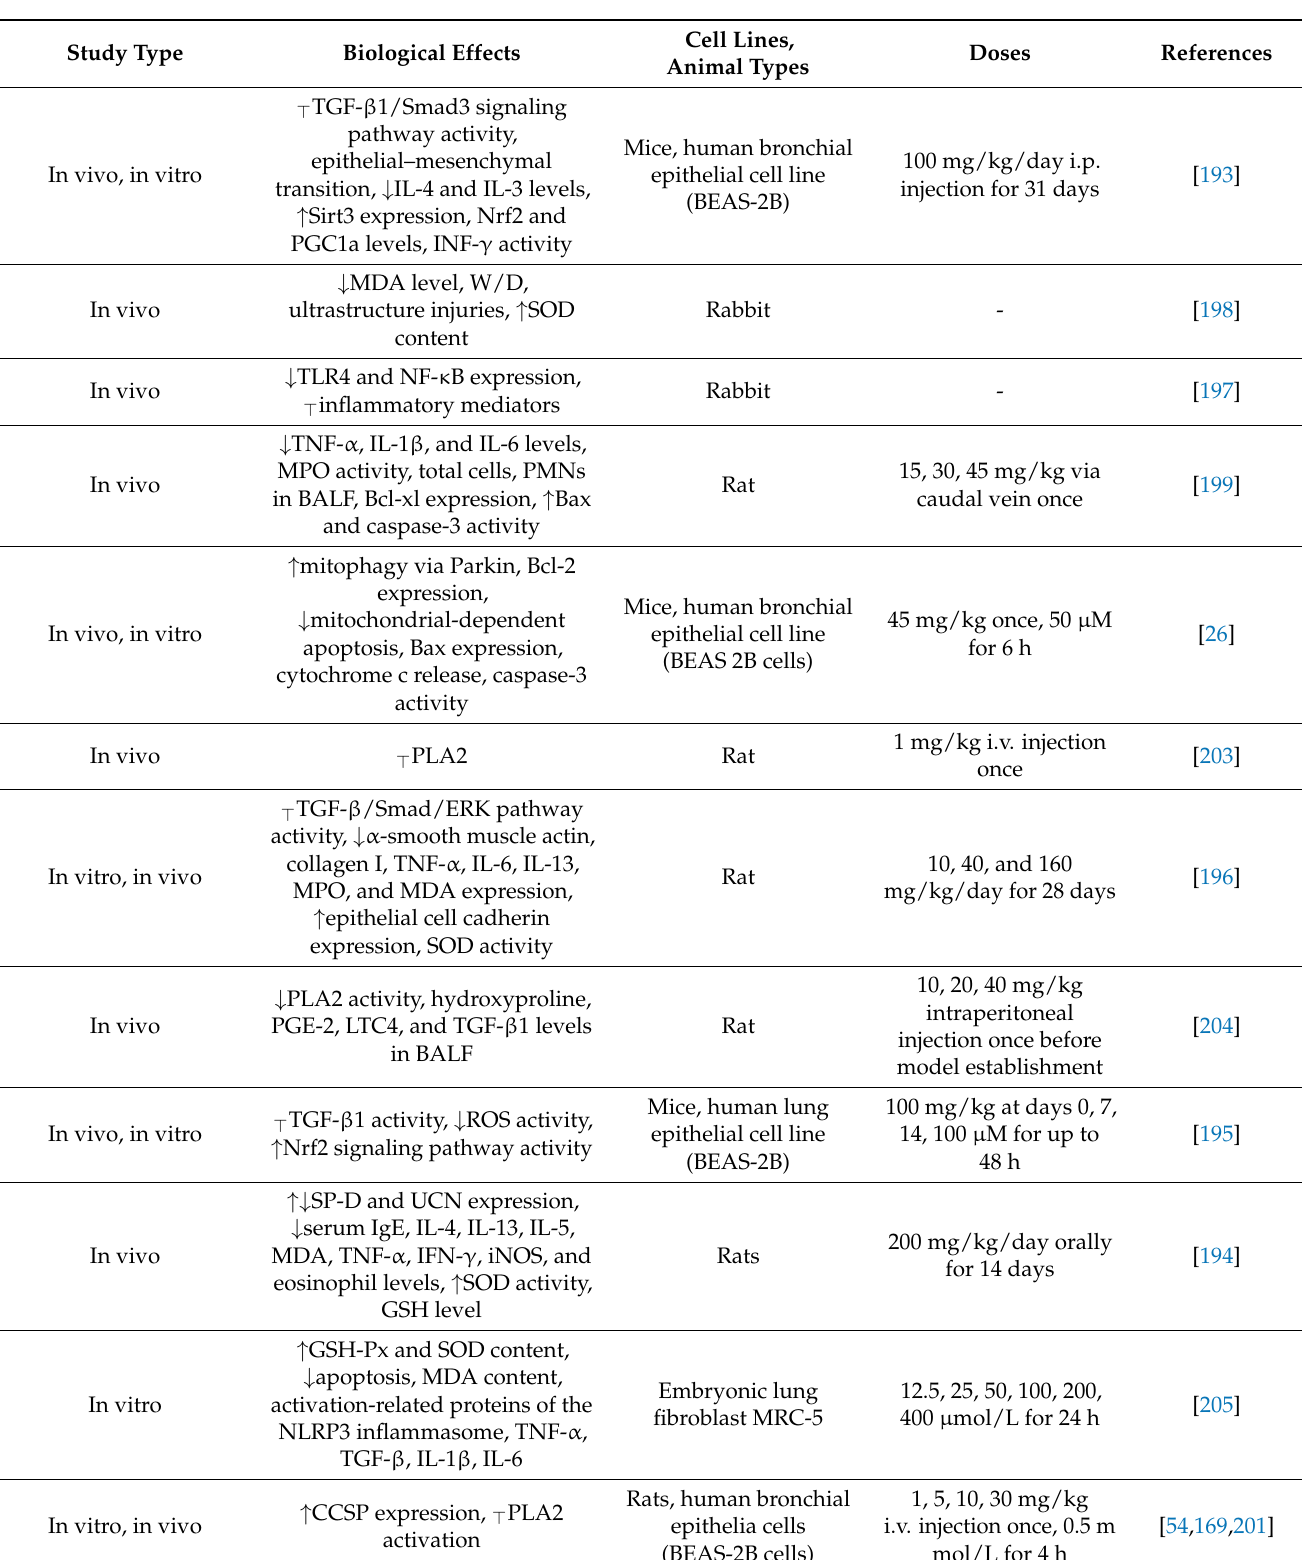
Table 6. Effect of polydatin on respiratory